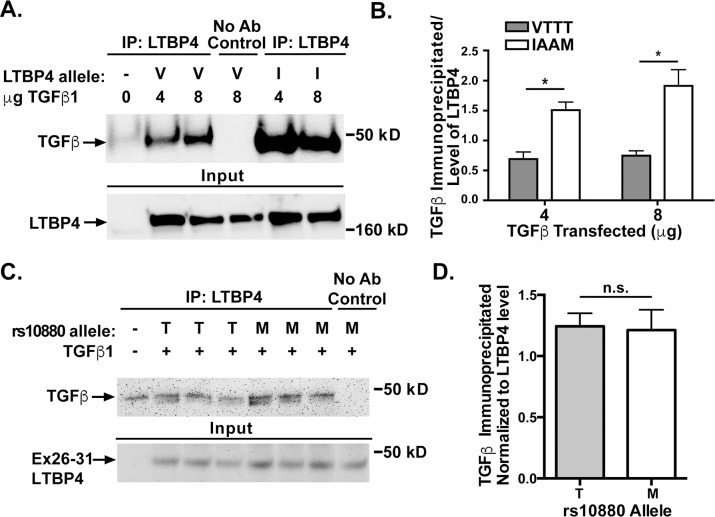
LTBP4-IAAM binds more TGFβ1 than LTBP4-VTTT.A. HEK293T cells were co-transfected with constructs expressing pro-TGFβ1 and either LTBP4-VTTT (V) or LTBP4-IAAM (I). Cell lysates were immunoprecipitated using an antibody to LTBP4 and immunoblotted using an antibody to the FLAG tag on TGFβ1. Both LTBP4-IAAM and LTBP4-VTTT bound pro-TGFβ1. B. The amount of TGFβ1 immunoprecipitated was quantified and normalized to the amount of LTBP4 expression (experiments performed in triplicate). Cells lines carrying the IAAM protective allele of LTBP4 immunoprecipitate more TGFβ1 than cell lines carrying the VTTT allele, (p = 0.0015). C. The carboxy terminal fragment of LTBP4 that contains rs10880 encoding either the “M” or “T” residue was expressed (Ex26-31) and tested for its interaction with TGFβ1. D. No significant difference was detected between the reference threonine (T)-containing and the protective methionine (M)-containing fragment of LTBP4 in its ability to interact with TGFβ1.